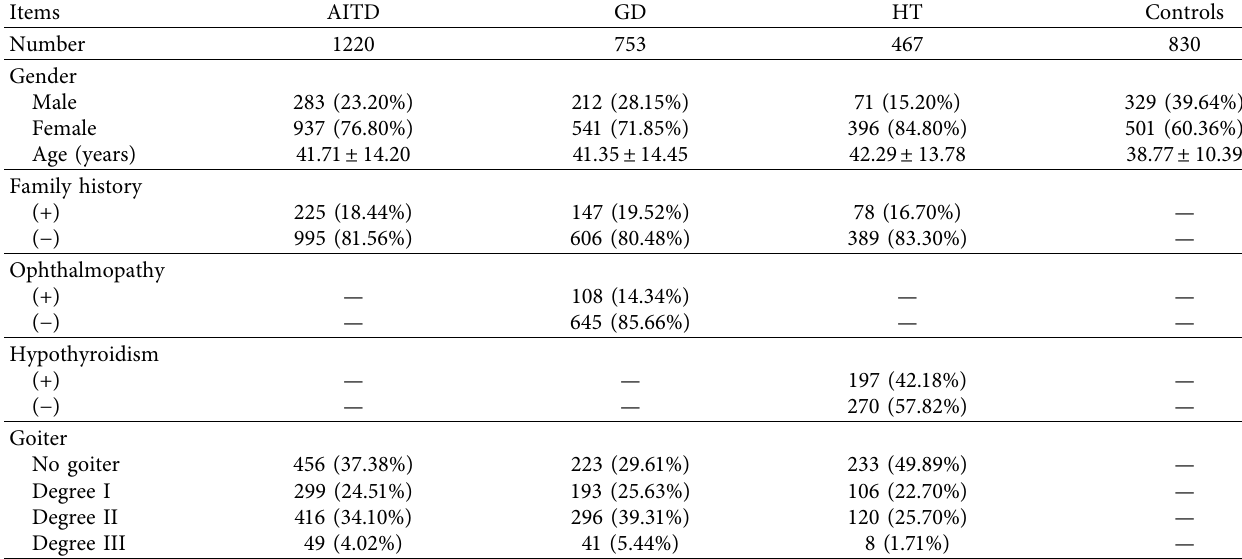
Table 2: Clinical features of subjects including AITD patients and